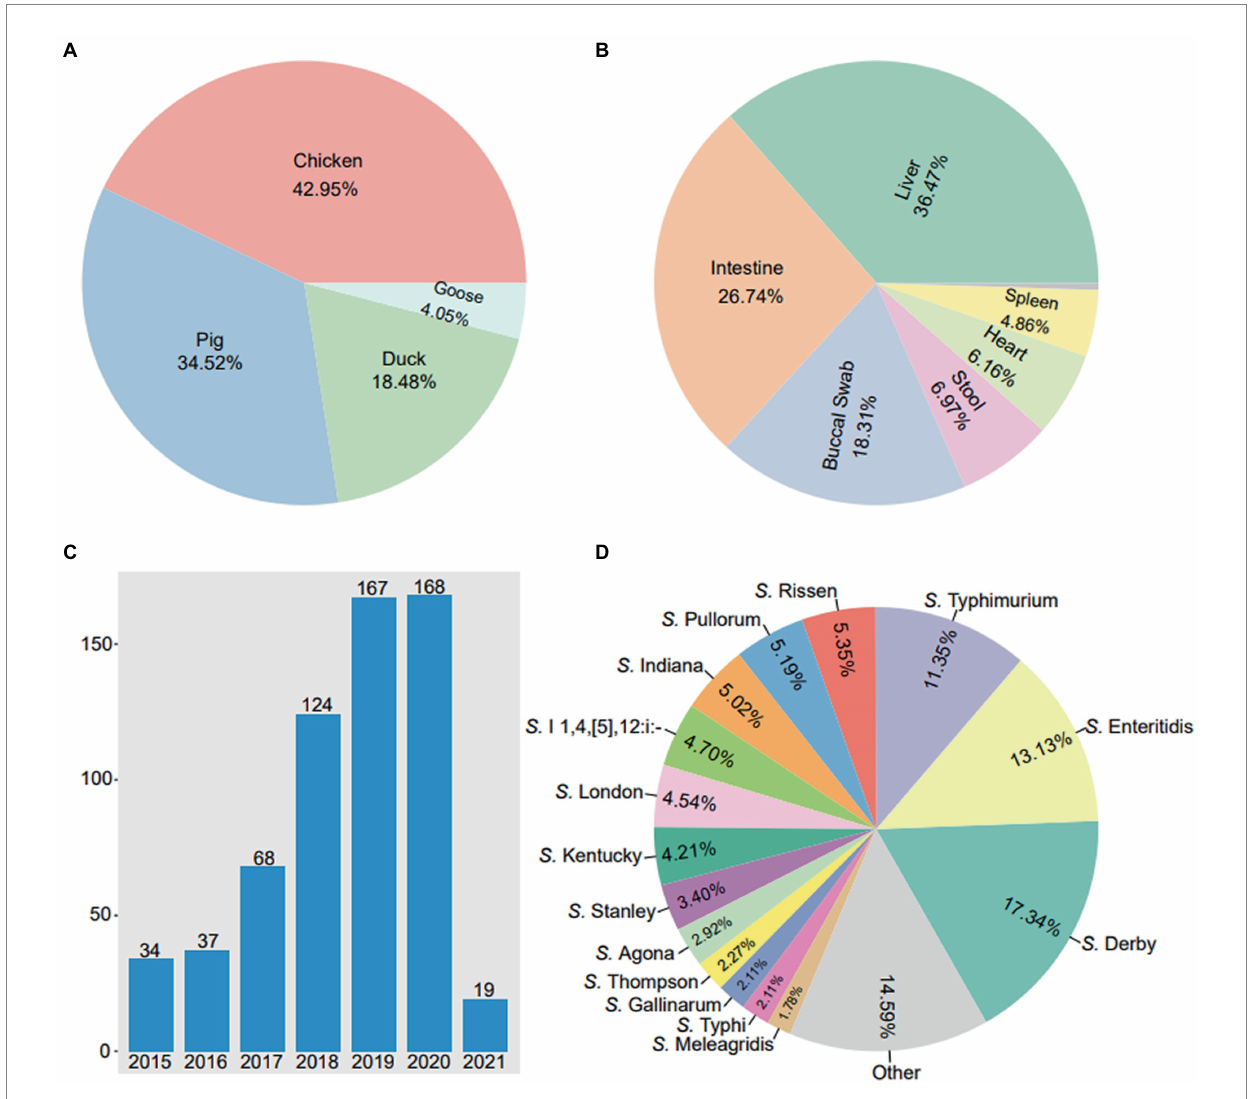
FIGURE 2 The prevalence of 617 Salmonella isolates from food animals in China. (A) The detection rates of Salmonella isolates in diffierent hosts. (B) The detection rates of Salmonella isolates in different body sites. (C) The annual number of Salmonella isolates in 2015 ~ 2021. (D) The detection rates of various serovars in 617 Salmonella